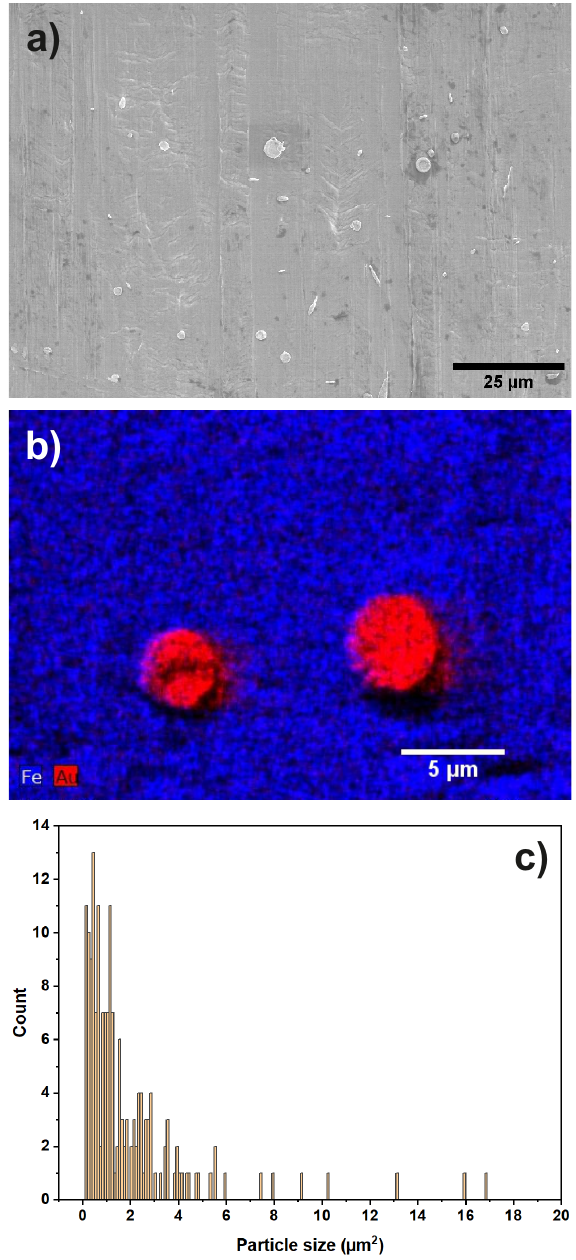
Figure 1. ( a ) SEM overview image of sample “Au”. Different shapes of Au particles (elongated, circular) are visible; ( b ) EDX map of two Au particles on the steel support; ( c ) particle size distribution of the catalyst